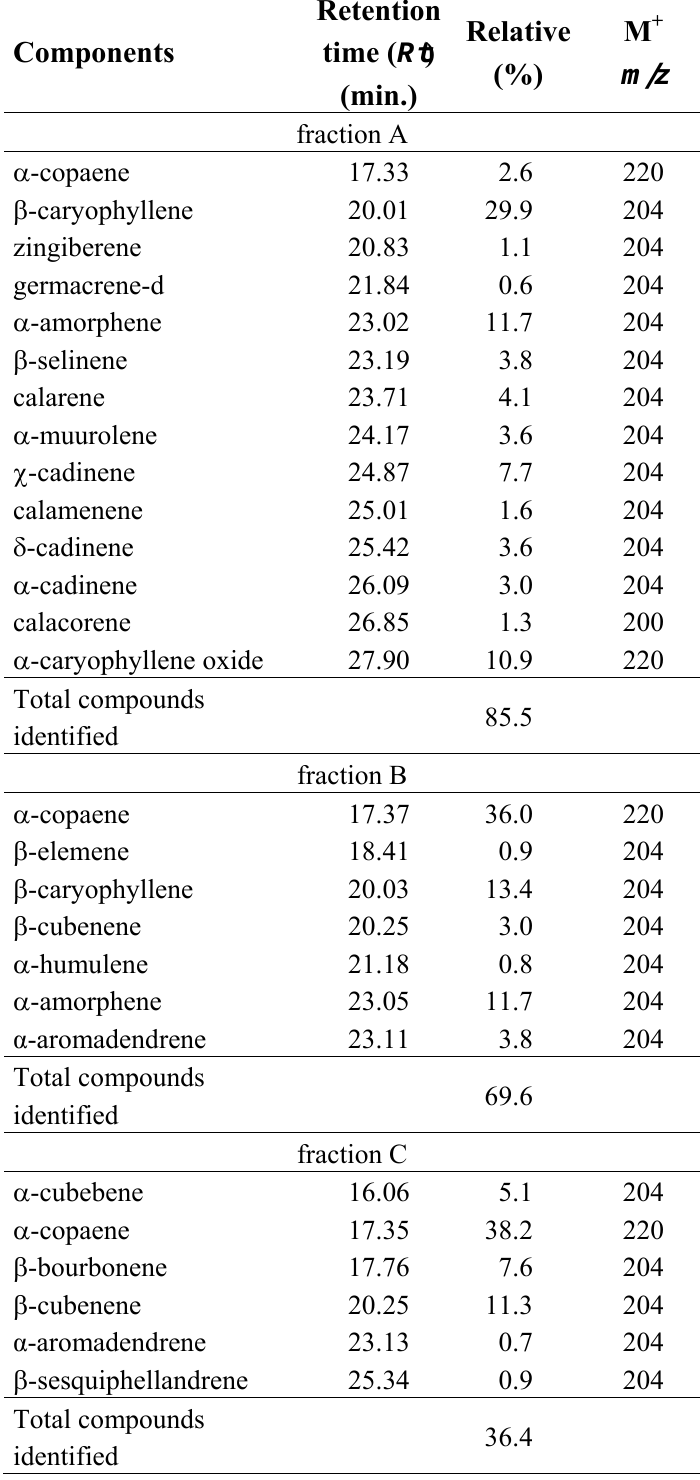
Table 2. Chemical composition of fractions A-D obtained by GC/MS a